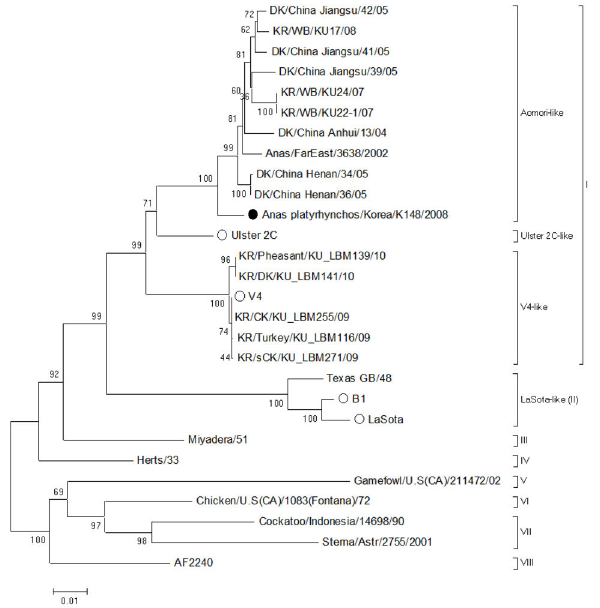
Figure 1. Neighbor-joining phylogenetic tree for the fusion gene of NDV isolates. Phylogenetic analysis was performed using the alignment of the first 1662 nucleotide sequence from the fusion gene coding region of NDV isolate. The K148/08 strain (●) was compared to commercial vaccine strains (○) obtained from the GenBank. The percentage of replicate trees in which the associated taxa clustered together in the bootstrap test (1000 replicates) were shown next to the branches.